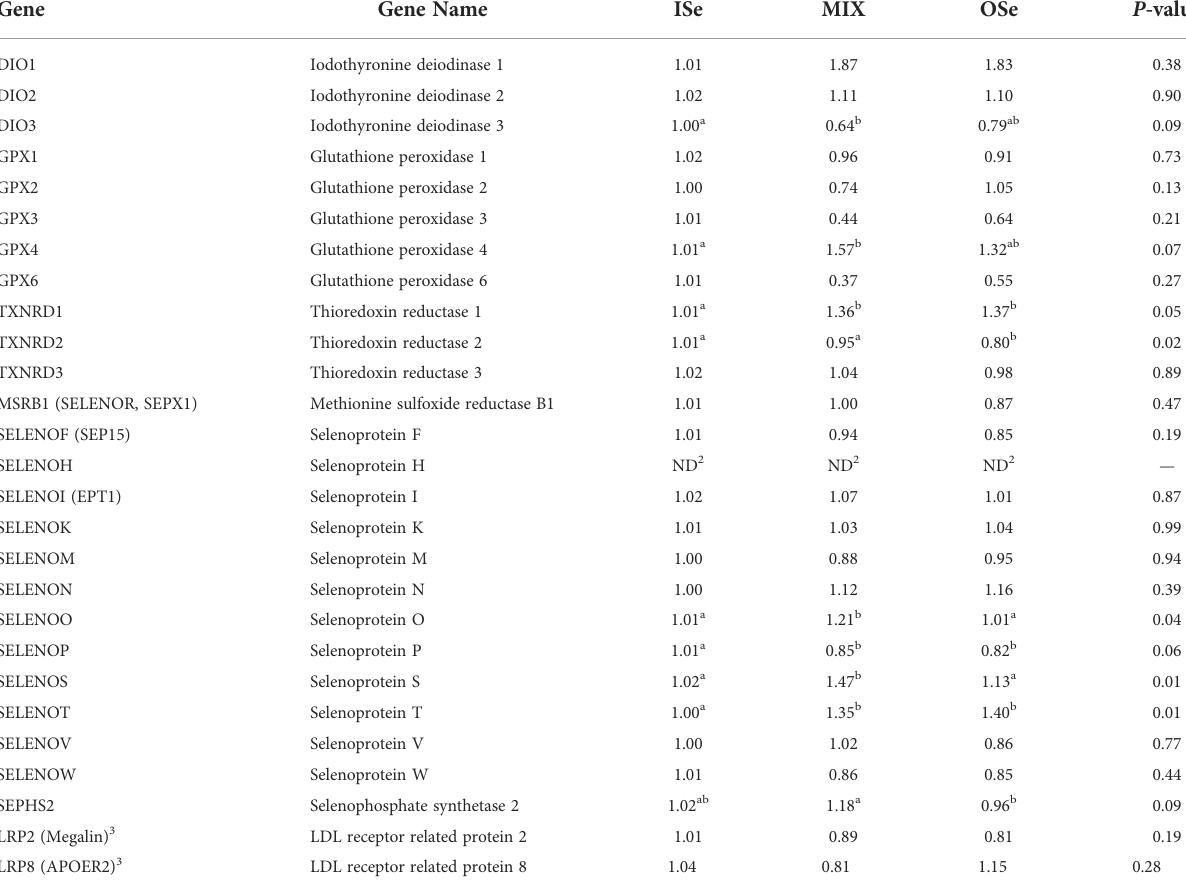
TABLE 5 Real-time RT-PCR-determined relative expression of selenoprotein genes in liver tissue of steers grazing endophyte-infected tall fescue and supplemented with 3 mg Se/d in vitamin-mineral mixes as either sodium selenite (ISe), SEL-PLEX (OSe), or a 1:1 mix of ISe and OSe (MIX) 1 .